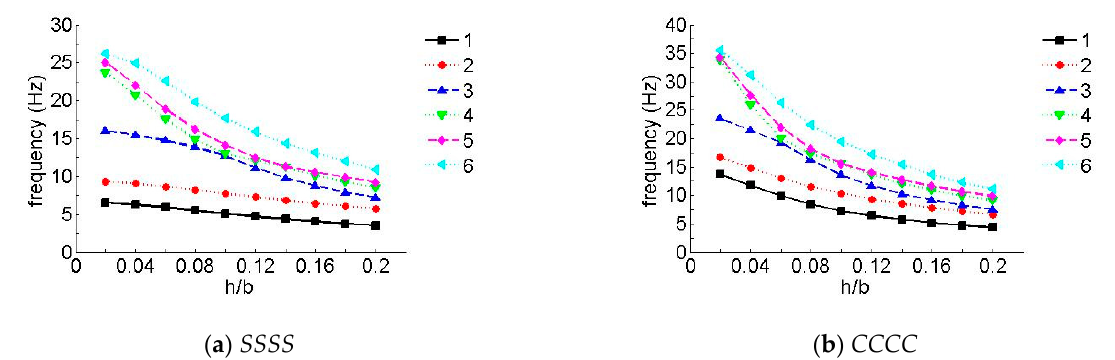
Figure 5. Nature frequency parameters for rectangular laminated plates with ECFF .